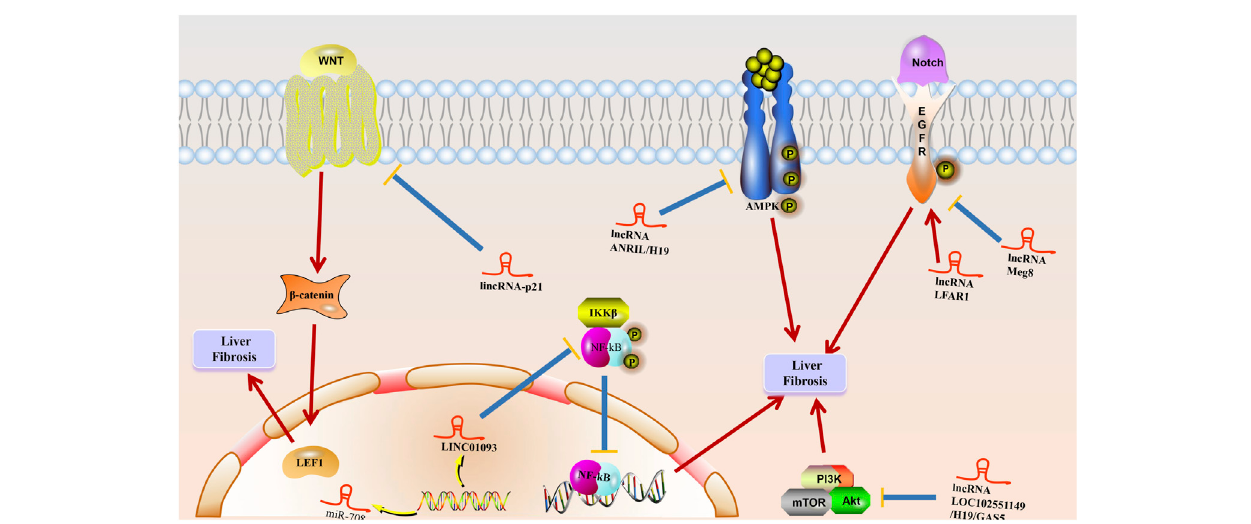
FIGURE4| ThemechanismoflncRNAtoliver fi brosis.Multiple stimulisuchaschronichepatitis B(CHB) damagehepatocytestoinitiatewoundhealingresponses, andLncRNAsplayaroleinpromotingactivationandapoptosisofhepaticstellatecellsandinducingepithelial-mesenchymaltransition(EMT)atmultiplestages,leadingto excessive accumulation of extracellular matrix (ECM) proteins in hepatocytes, resulting in liver fi brosis generation and progression.